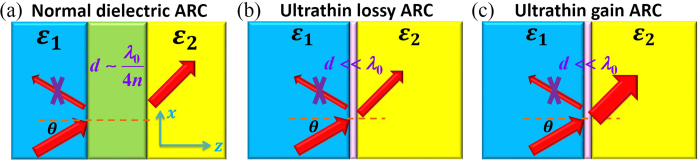
Schematics of different kinds of ARCs.Illustration of three types of ARCs by using (a) a quarter-wave dielectric layer, (b) an ultrathin layer of lossy media, and (c) an ultrathin layer of gain media. The thicknesses of the ultrathin layers are in deep subwavelength scale.